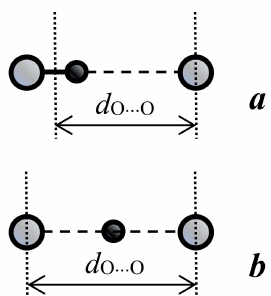
Figure 22. X-ray measurement of d O ··· O distance at localization of a proton near the donor ( a ) and in the midpoint of the donor-acceptor bond ( b ). The true distance between the centers of oxygen atoms in the figure is the